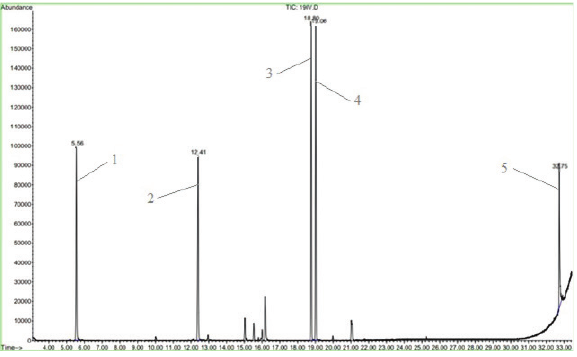
Figure 8. Chromatogram of free carbohydrates in the herbal mixture No. 13 (1 – arabinose, internal standard; 2 – glucose; 3–4 – fructose; 5 – sucrose). Table 2. The results of the GC-MC analysis of carbohydrates in the herbal mixtures. No. of peak on Retention Identified chromatograms time, min substance